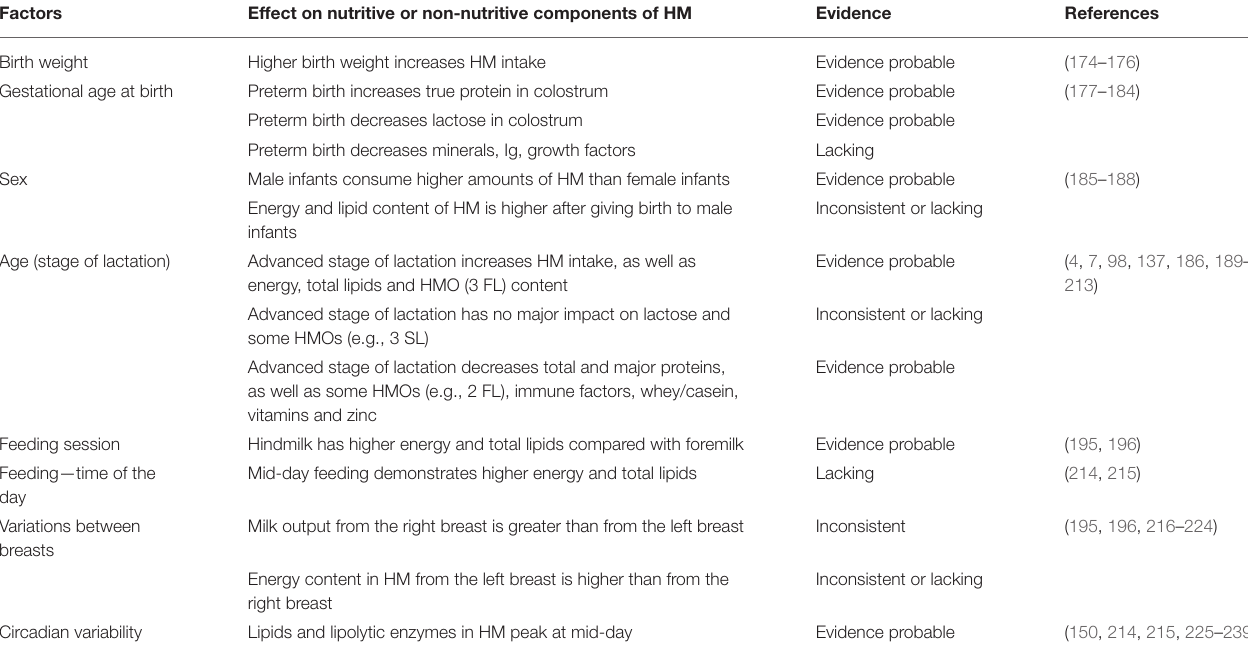
TABLE 3 | Infant-related factors affecting nutritive and non-nutritive components of human